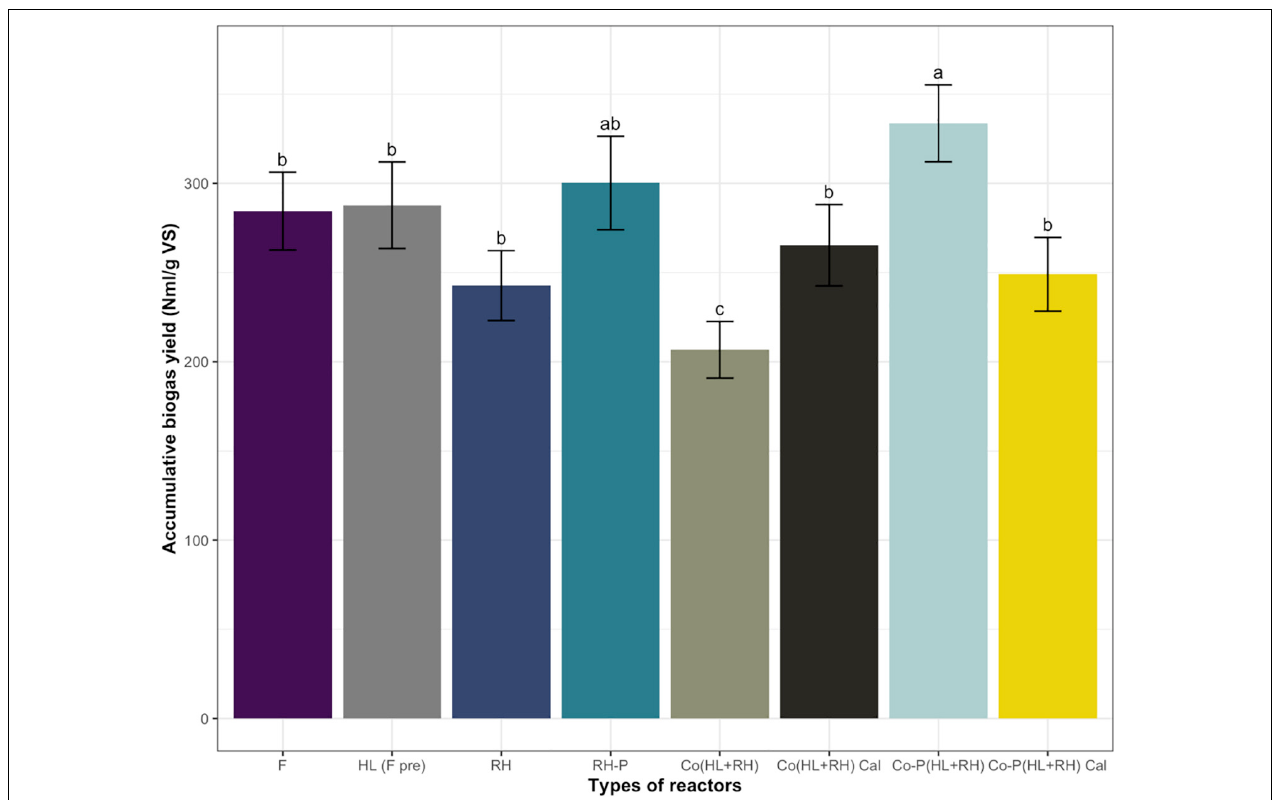
FIGURE 2 | Comparison of accumulative and calculated biogas yield (calculated from mono-digestion of hydrolysate and rice husk) from F (feathers), HL-(F-pre) (feathers hydrolysate biologically pretreated), RH (rice husk), RH-P (rice husk pretreated), Co (HL+RH) [co-digestion (hydrolysate + rice husk)], Co (HL+RH) Cal [co-digestion (hydrolysate + rice husk) calculated from the yield of hydrolysate and rice husk], Co-P (HL+RH) [co-digestion with pretreated (hydrolysate + rice husk)], Co-P (HL+RH) calculated [co-digestion with pretreated (hydrolysate + rice husk) calculated from the yield of hydrolysate and rice husk]. Means having the same letter are statistically similar as per the Tukey test at p <